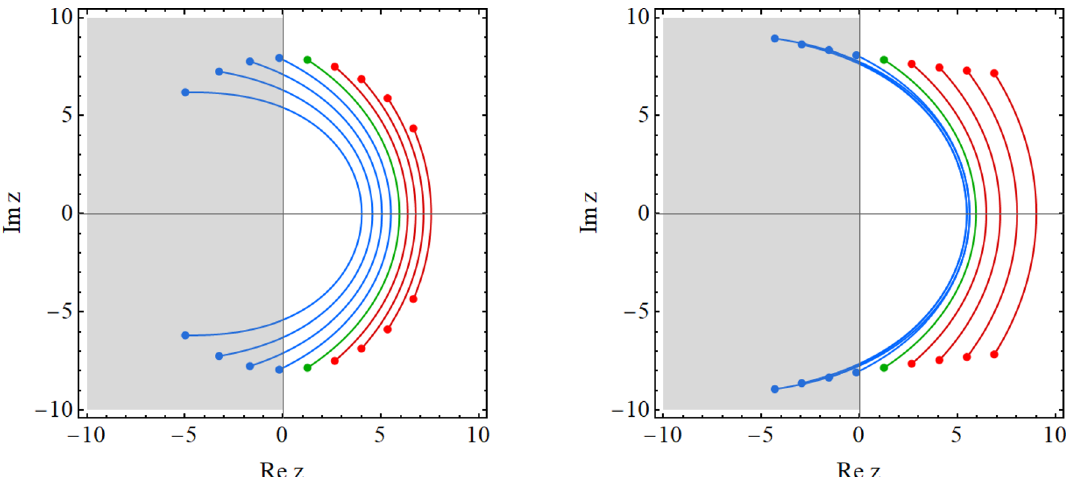
Figure 10 . The Stokes lines for spin-1 bosons (left panel) and spin-1/2 fermions (right panel) in dS with (cid:15) -type deviation and (cid:15) = 0 . 1 . In both panels, the momentum k is fixed to have a dimensionless chemical potential ranging over ˜ κ p = − 8 , − 6 , · · · , 6 , 8 (from left to right, and the green lines correspond to the case without chemical potential), with spin-1 boson mass and spin- 1/2 fermion mass µ p = ˜ m p = 10 . The gray region with Re z < 0 cannot be reached